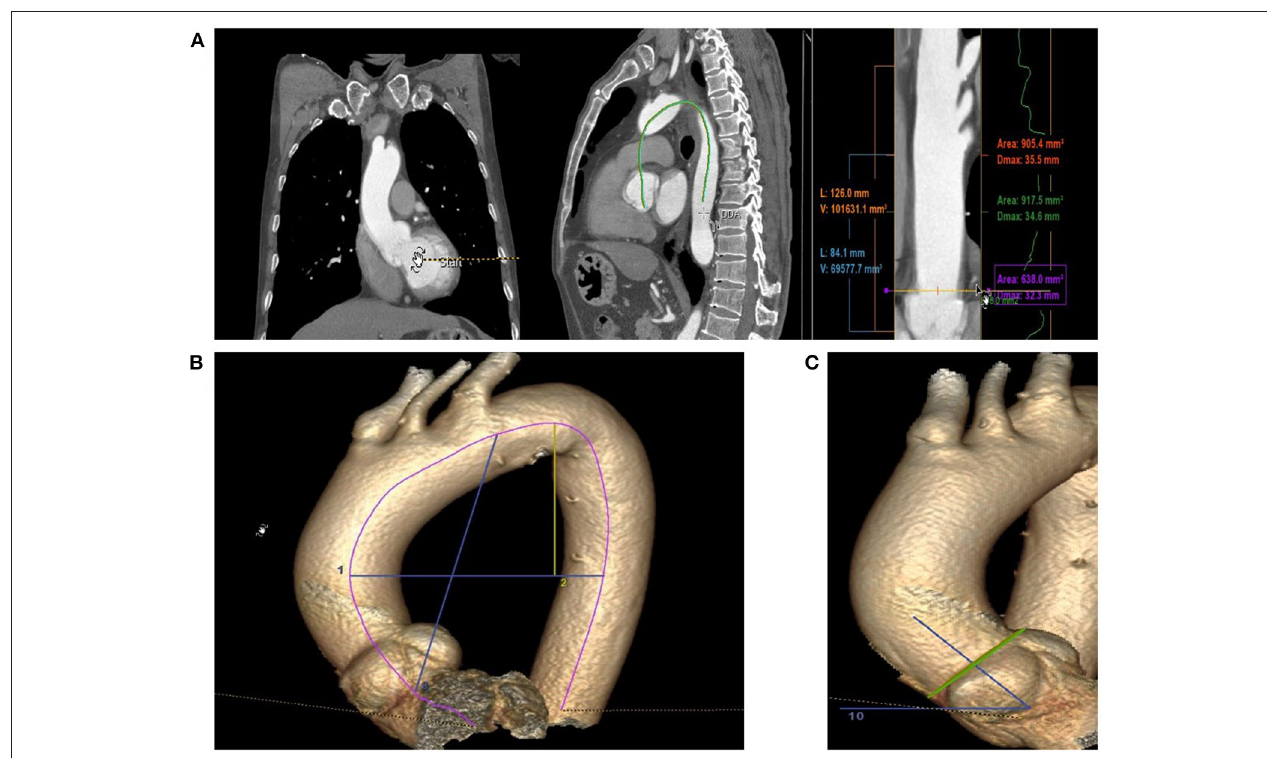
FIGURE 1 | The methods of Aortic morphological examination; (A) Markers are placed from the aortic root to the furthest distal end of the visible aorta, ensuring accurate coverage of the aortic arch and the measurement of Ascending Aorta Diameter and Length. (B) Measurement of ABI and HWR; the line 8: Straight line distance from the aortic root to the opening of left subclavian artery; line 2: the maximal horizontal distance between the midpoints of the ascending and descending aorta close to the axial plane; line 1: the maximal vertical distance between line 2 and the highest midpoint of the aortic arch. (C) The angle between the vertical line of the STJ plane and the horizontal